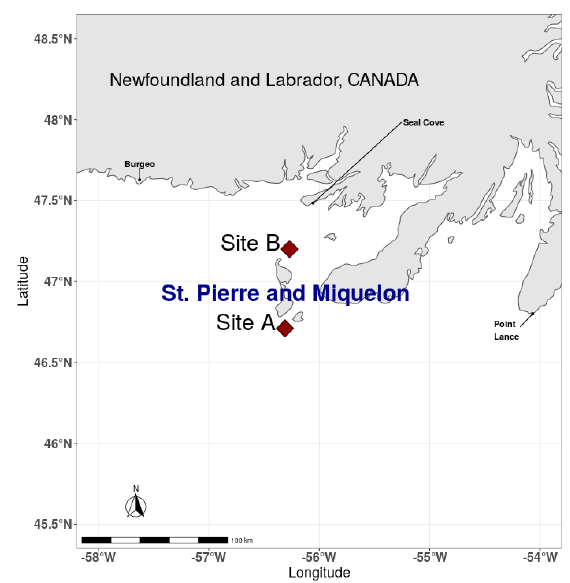
Figure 1. Deployment